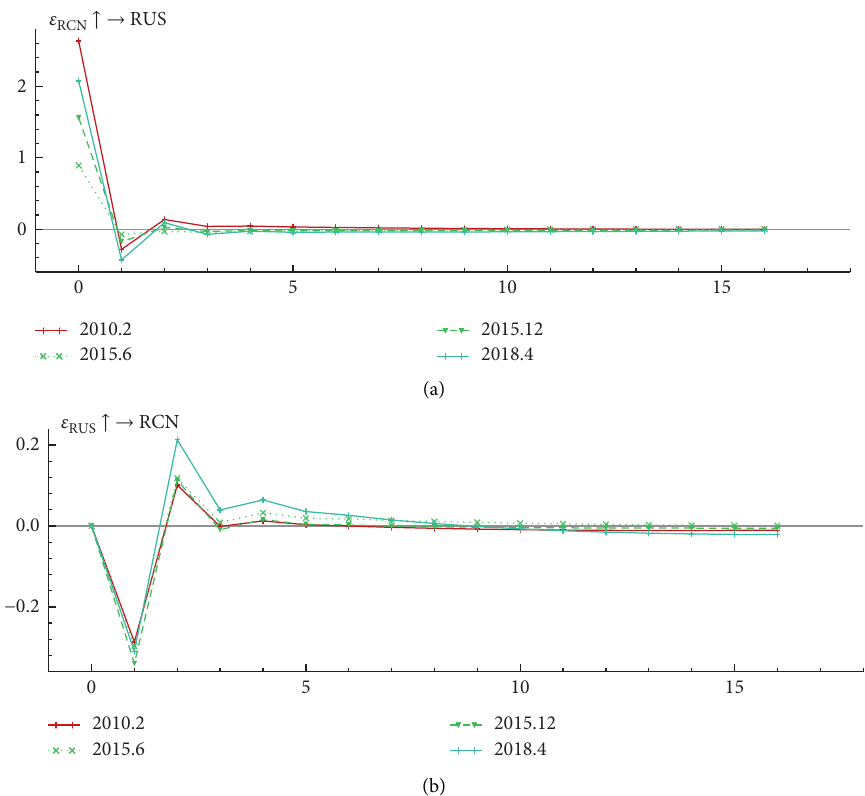
Figure 13: The impulse response of China and the US stock market return at different time